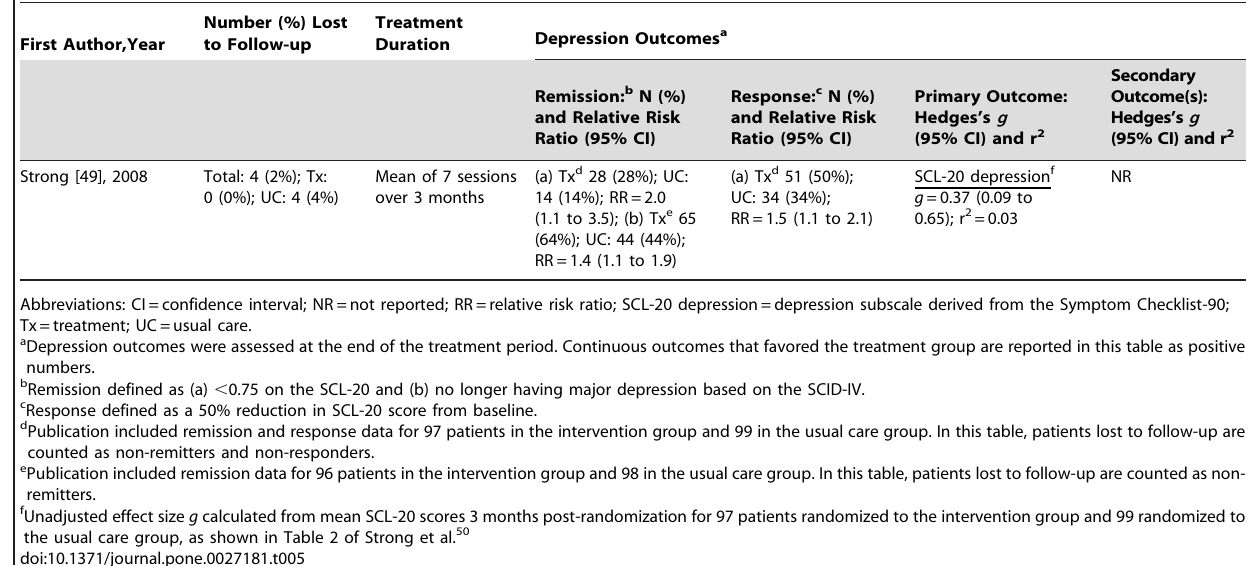
Table 6. Assessment of Risk of Bias in Randomized Controlled Trial in Key Question # 2 (Treatment).